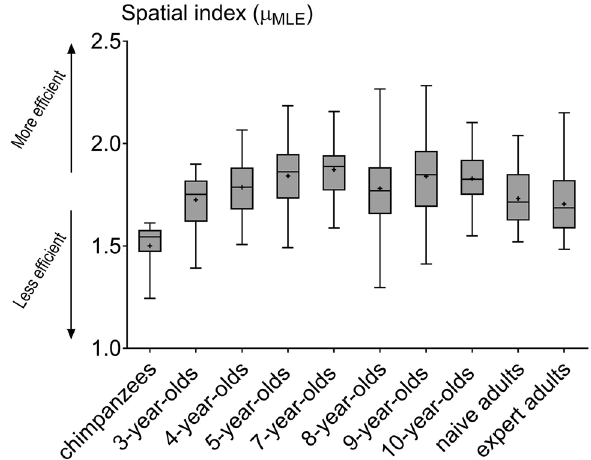
Figure 1. Boxplots of the spatial index μ MLE for each group, i.e. chimpanzees and humans (children and adults). Since the condition factor is not present in the selected model, all drawings were studied without distinction of conditions. Each boxplot depicts the median (bold bar), 25–75% quartiles (box), mean (cross) and outliers (points).